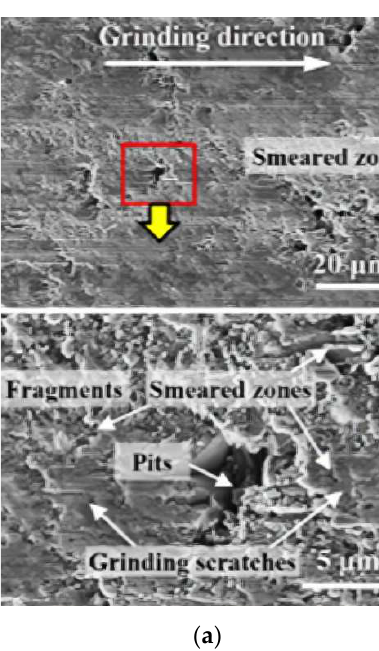
Figure 9. Material surface after machining at different cutting speeds. ( a ). 𝑣 𝑠 = 20.4 m/s , ( b ). 𝑣 𝑠 = 222.3 m/s . Reprinted/adapted with permission from Ref. [24]. 2022, Elsevier Ltd. ( b ). v s = 222.3 m/s. Reprinted/adapted with permission from Ref. [24]. 2022, Elsevier